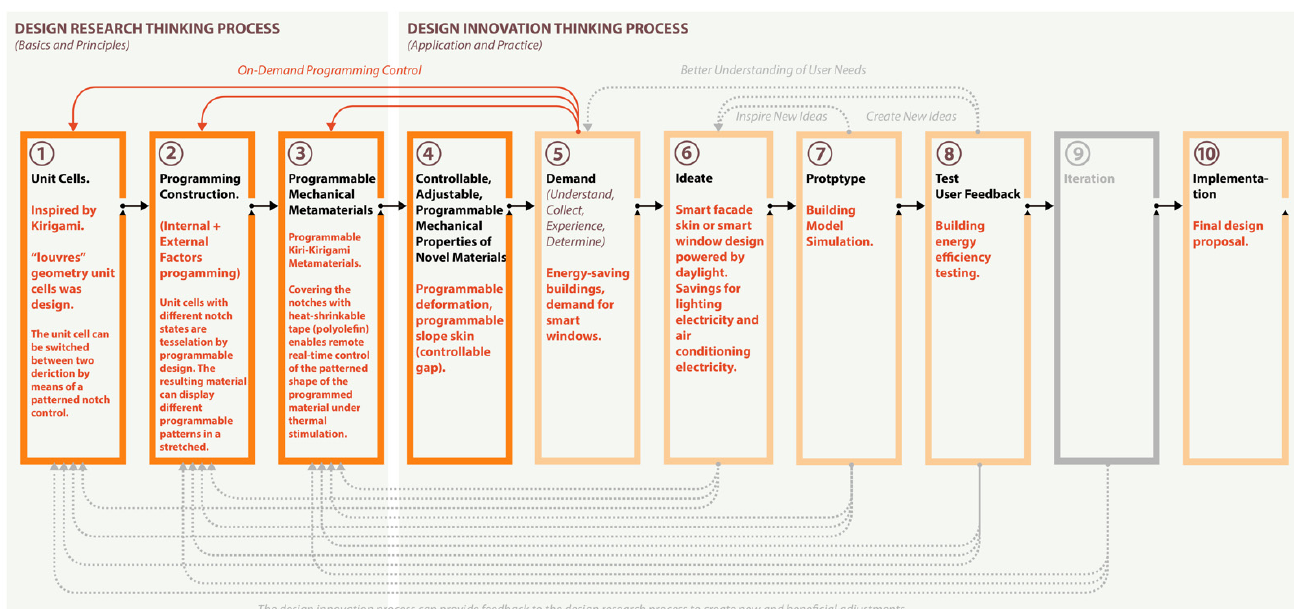
Figure 17. Combined with the IDTPMM process model, this study analyzes and sorts out the design thinking process of Tang et al.’s energy-saving building skin design